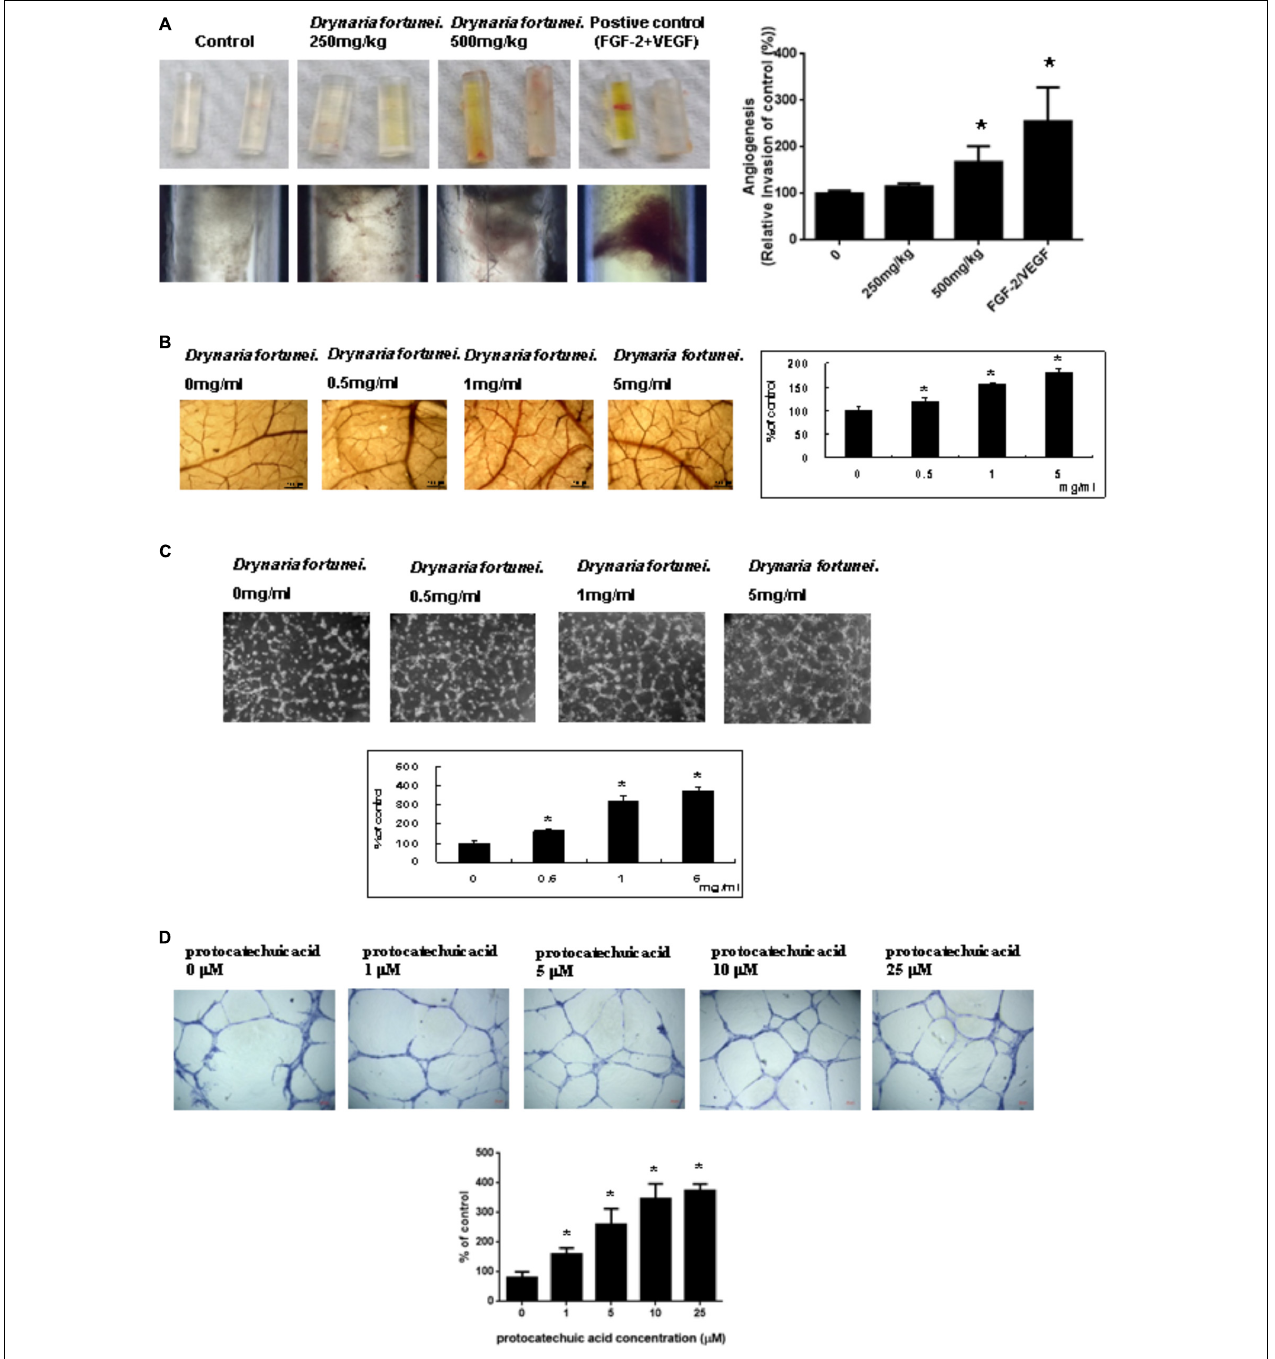
FIGURE 2 | D. fortunei promoted angiogenesis both in vivo and in vitro . Angiogenesis assays were performed in vivo and ex vivo models. (A) Directed in vivo angiogenesis assay (DIVAA) showing silicone tubes was applied in this study. Angioreactors were implanted subcutaneously into the dorsal areas of nude mice for 2 days, followed by feeding with and without D. fortunei at 250 mg/kg and 500 mg/kg for 15 days to allow new vessels to infiltrate. Then, the mice were sacrificed and the angioreactors removed, photographed, and calculated. (B) The CAM of 10-day-old chick embryos was used as an ex vivo model. The vessel density of CAM was increased with a dose-dependent manner in line with the concentrations of D. fortunei . The CAM tissues were examined for angiogenesis under a stereomicroscope (magnification, × 16) as indicated concentrations after 48 h incubation. (C) D. fortunei increased ECM gel-induced capillary tube formation in a dose-dependent manner. HUVECs were seeded to the Matrigel ECM gel layer in 24-well culture plate with or without treatment of D. fortunei at various concentrations for 24 h. (D) PA as a positive control also enhanced ECM gel-induced capillary tube formation dose-dependently. HUVECs were seeded to the Matrigel ECM gel layer in 24-well culture plate with or without treatment of PA at various concentrations for 24 h. Data were mean ± SD calculated from three individual experiments. An asterisk demonstrated the significant difference ( ∗ P < 0.05) compared with control.